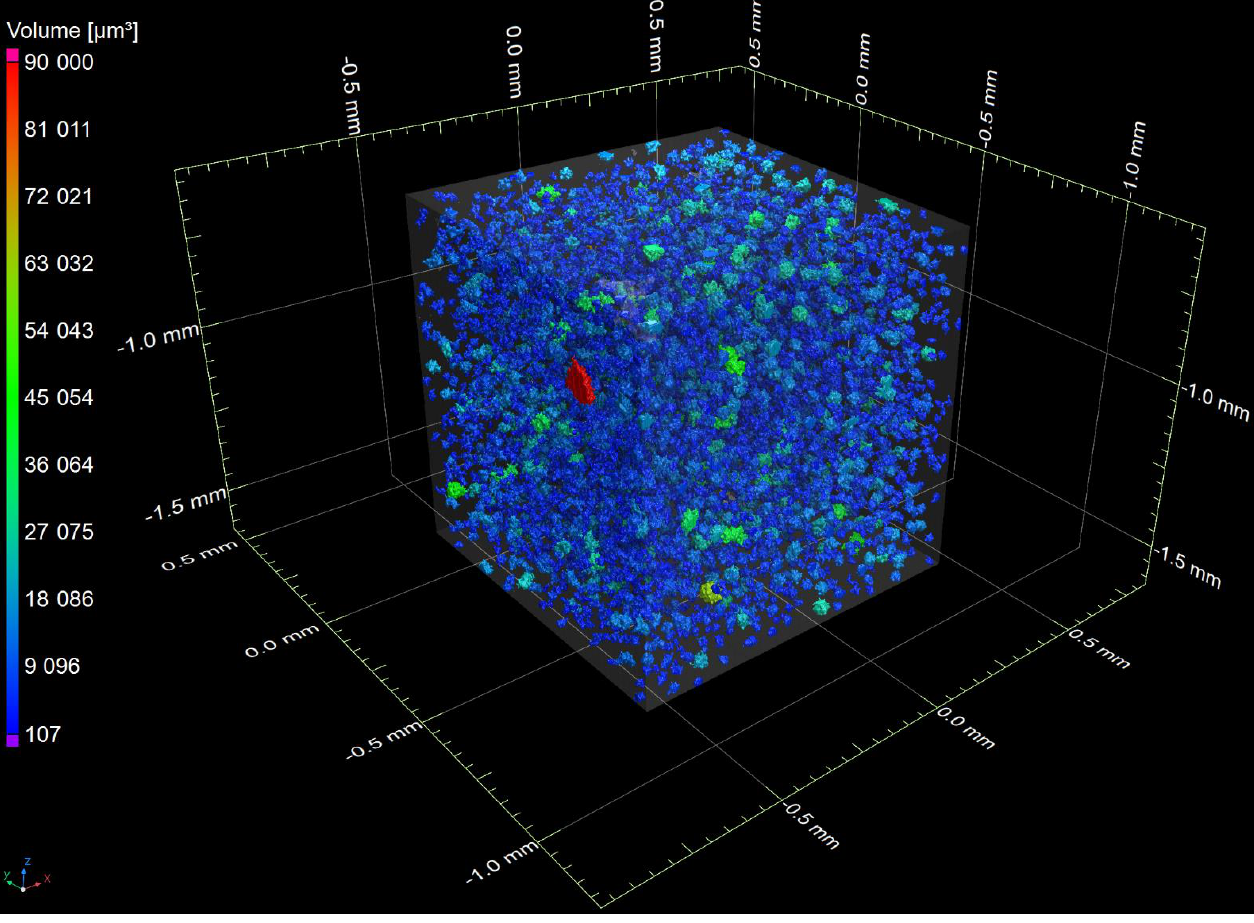
Figure 7. A spatial image showing a fragment of the sample after graphite analysis in ductile iron. Partial transparency of the detail was used.